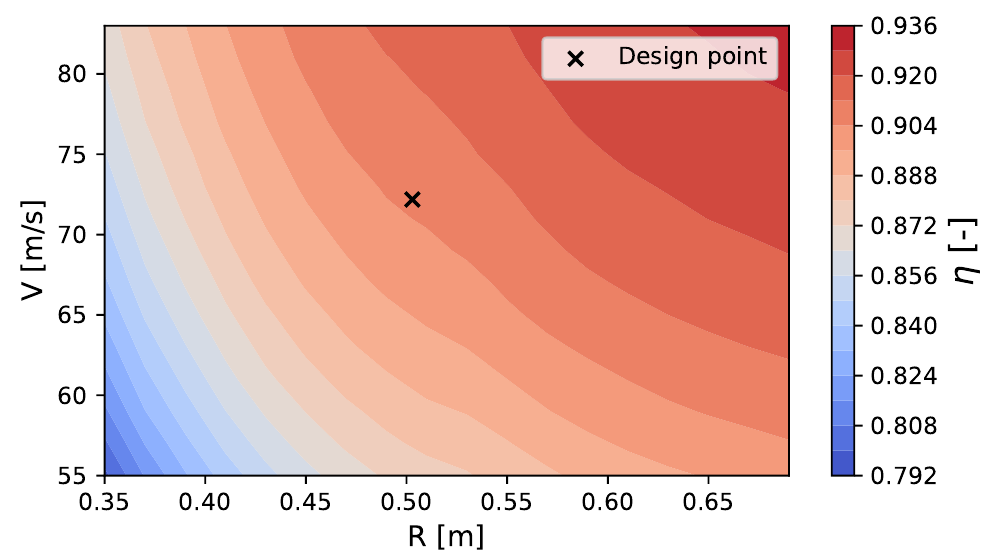
Figure 10. Sensitivity analysis of propeller efficiency in the design procedure to variations in freestream velocity and propeller radius.